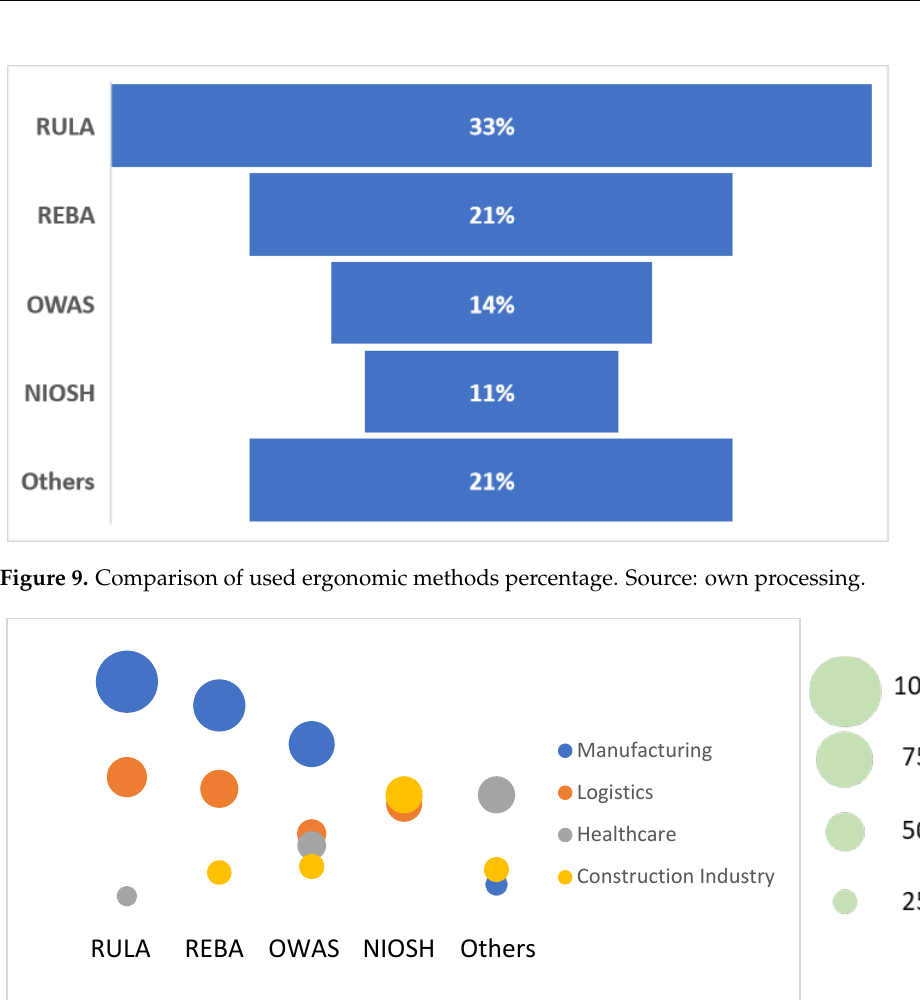
Figure 10. Graphical representation of the correlation between the ergonomic methods used and the areas in which the assessment is performed.